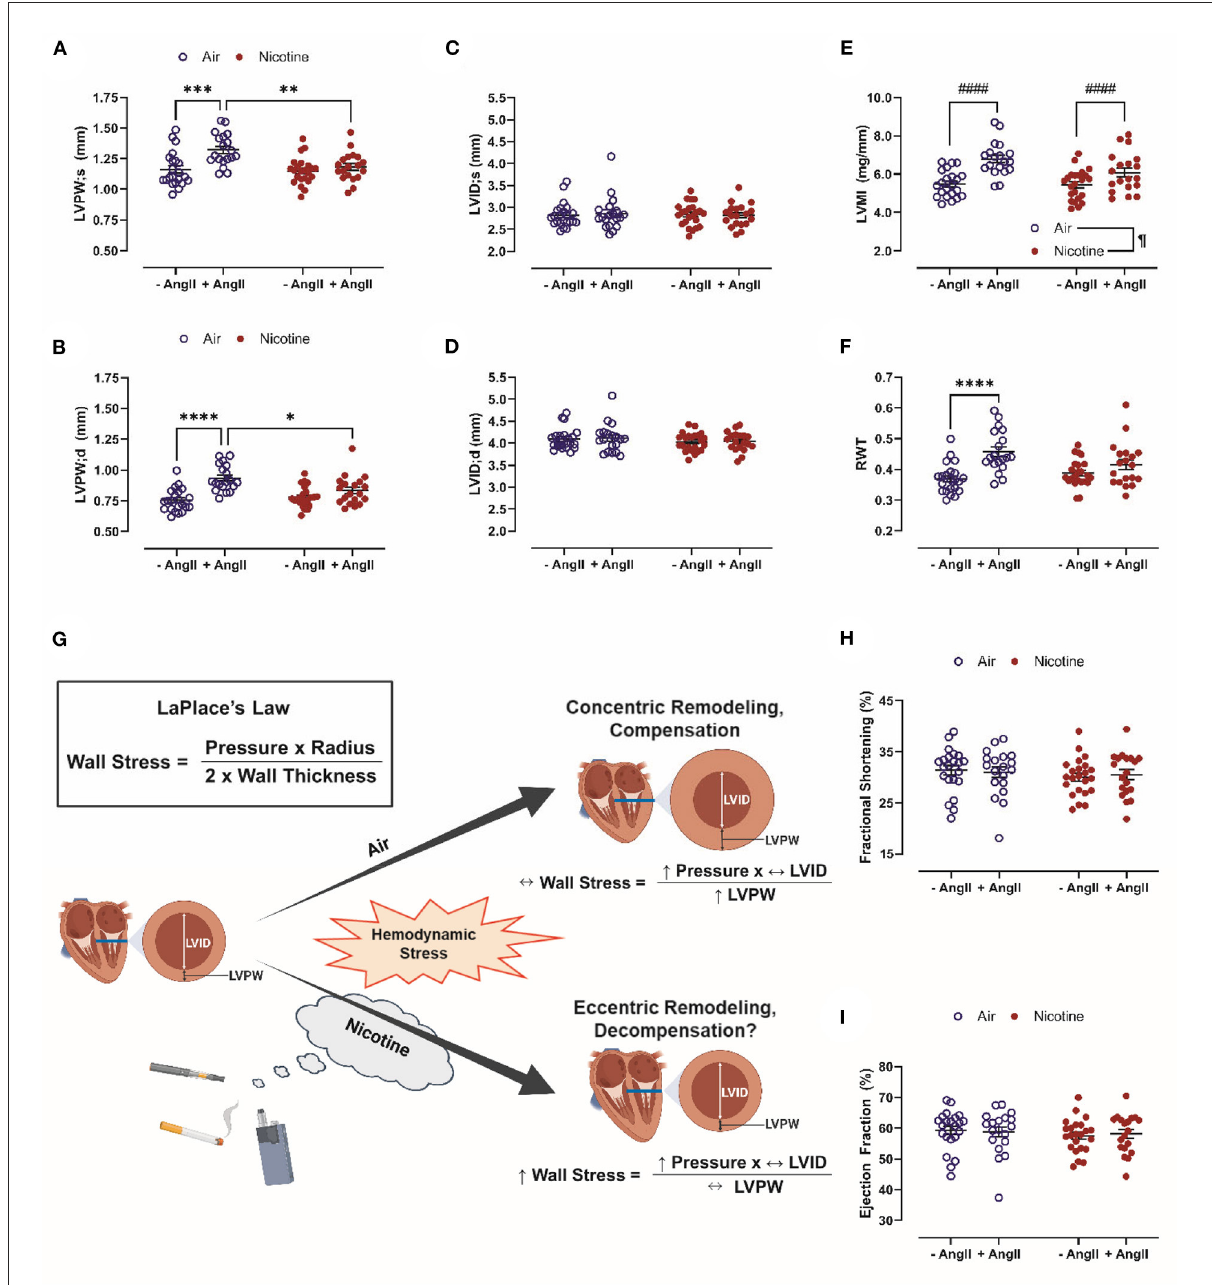
FIGURE1 Chronic, inhaled nicotine drives maladaptive cardiac remodeling in mice undergoing hemodynamic stress. (A,B) Inhaled nicotine abrogates angiotensin (Ang)-II-induced left ventricular (LV) posterior wall thickening at systole and diastole (LVPW;s and ;d). (C,D) Neither Ang-II nor nicotine inhalation affect LV chamber diameter (LVID;s and ;d). (E) Ang-II increases LV mass indexed to tibia length (LVMI). (F) Ang-II increases relative wall thickness (RWT) in air-exposed mice only. (G) Inhaled nicotine exposure causes a shift from concentric to eccentric hypertrophy during hemodynamic stress which may exacerbate LV wall stress and promote decompensation based upon LaPlace’s Law. (H,I) Neither Ang-II nor nicotine affect LV function measured by fractional shortening and ejection fraction. N = 19–23 per group. Data are displayed as mean ± SEM. * P < 0.05, ** P < 0.01, *** P < 0.001, **** P < 0.0001 (two-way ANOVA with Tukey-Kramer post hoc test); #### indicates a main effect of Ang-II ( P < 0.0001, two-way ANOVA); ¶indicates a main effect of nicotine ( P < 0.05, two-way ANOVA). Figure 1G was created with